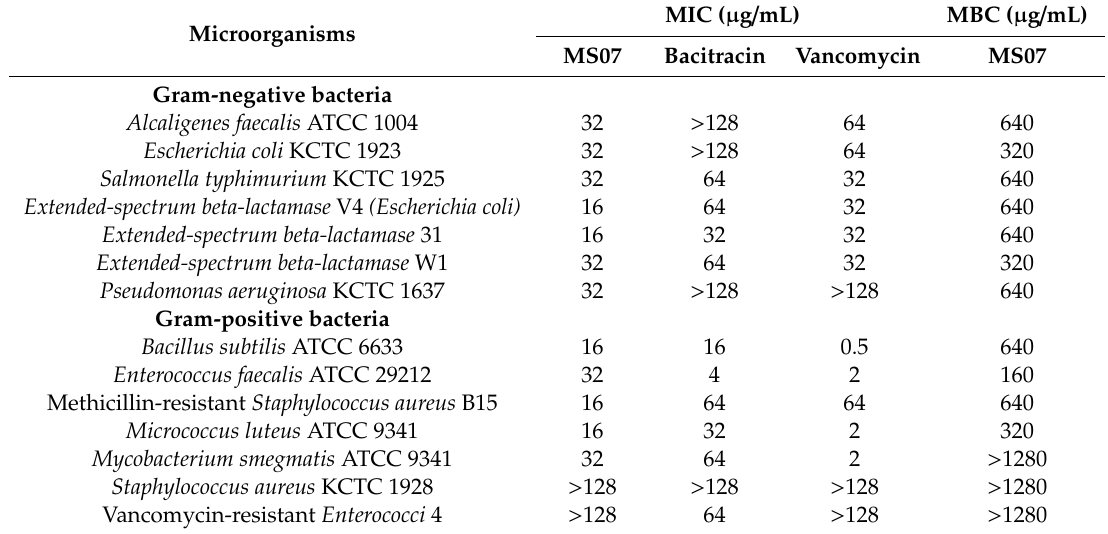
Table 5. Antimicrobial spectrum of peptide